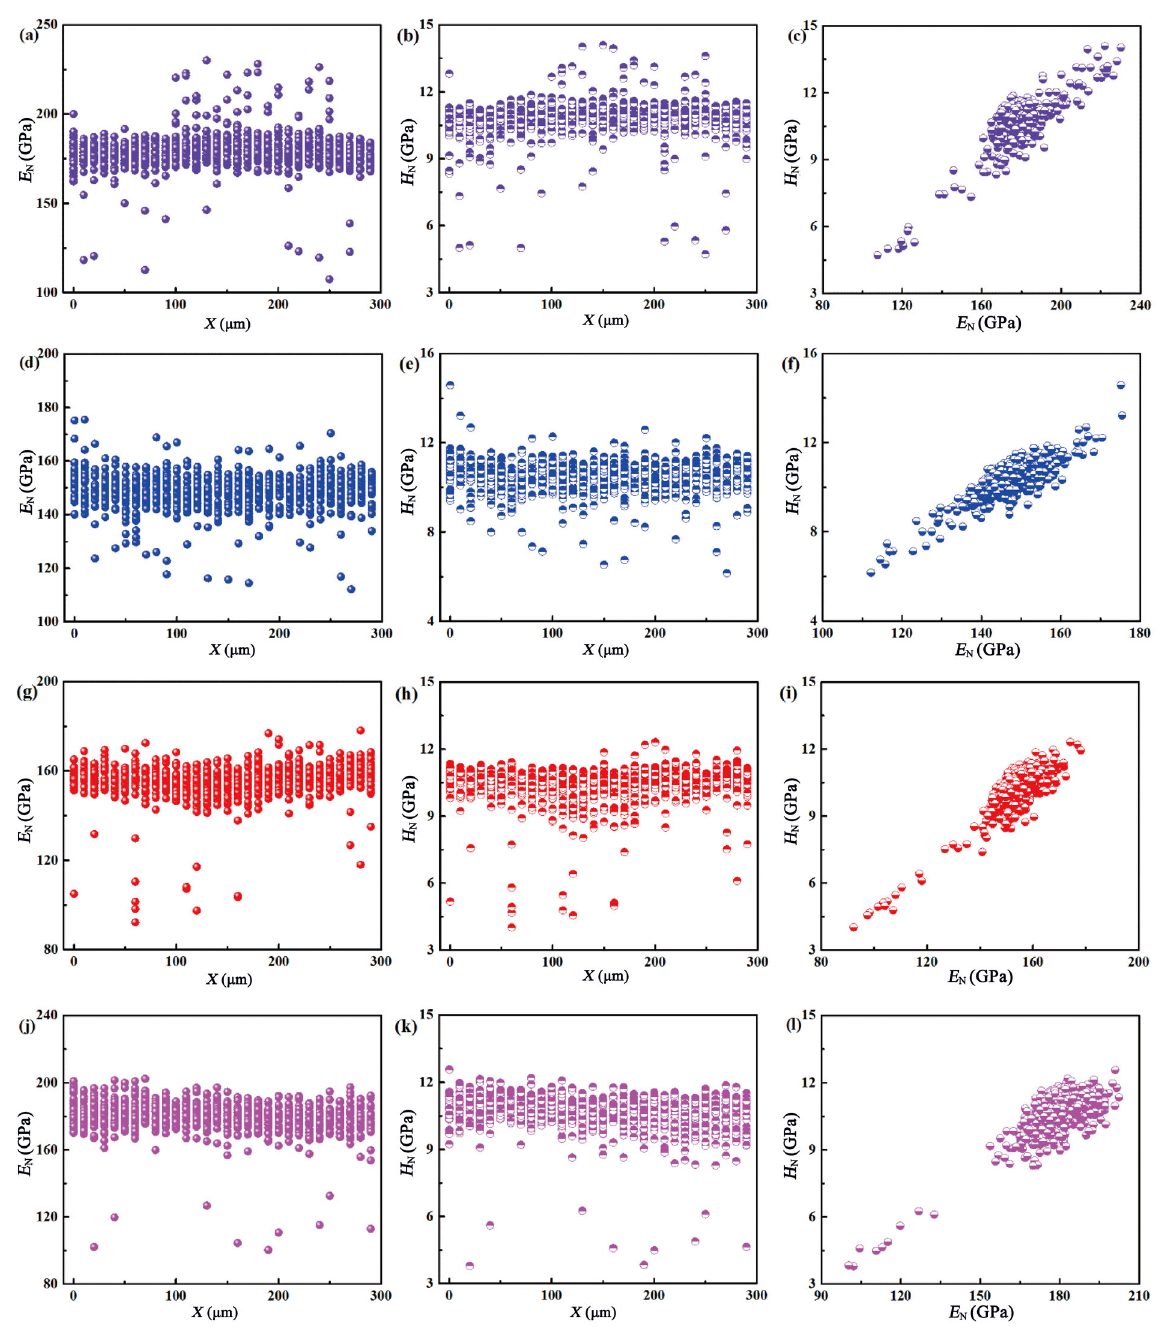
Fig. 7 Distributions of numerical values of nano-Young’s modulus and hardness for HEP RETa 3 O 9 ceramics: (a–c) (La 1/5 Pr 1/5 Dy 1/5 Ho 1/5 Tm 1/5 )Ta 3 O 9 (5HEP-1), (d–f) (Gd 1/5 Dy 1/5 Ho 1/5 Er 1/5 Tm 1/5 )Ta 3 O 9 (5HEP-2), (g–i) (La 1/6 Sm 1/6 Eu 1/6 Dy 1/6 Ho 1/6 Tm 1/6 )Ta 3 O 9 (6HEP-3), and (j–l) (Eu 1/6 Gd 1/6 Dy 1/6 Ho 1/6 Er 1/6 Tm 1/6 )Ta 3 O 9